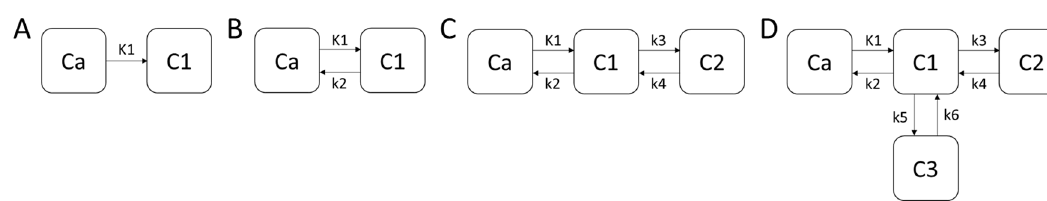
Figure 3. The block diagrams ( A ) is the most simplistic model achievable and has been used to describe trappable tracers for blood flow determination such as microspheres [192] (Equation 6), while ( B ) represents a similar model, but the tracer is not trapped in the C1 compartment, thus allowing efflux back into the blood as with radioactive water studies [178] (Equation 7). In diagram ( C ), the model has been used to describe the binding of ligands to receptor systems, where the C1 compartment represents the interstitial space, and C2 is the receptor complex on the tissue of interest, such as for glucose metabolism [193] or P2X7 receptor binding [173] (Equations 8–9). Lastly, ( D ) has been used to describe binding to the receptor system described in ( C ), but the C3 compartment represents the non-specific binding (Equations 10–12) [194].